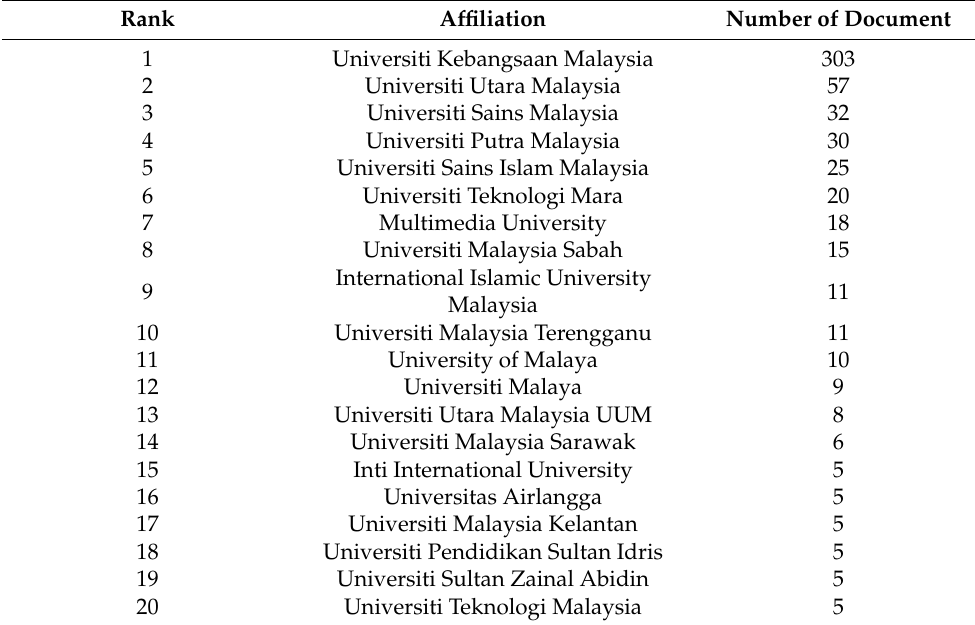
Table 3. Top 20 Affiliations of Jurnal Pengurusan